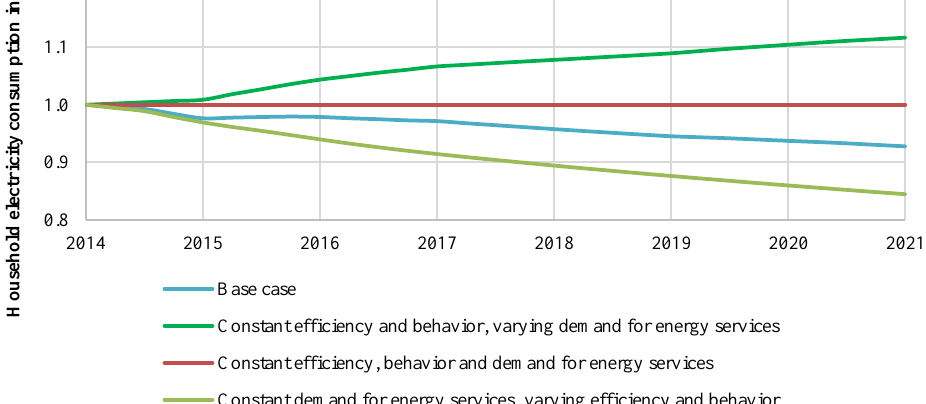
Fig. 13. Total household electricity consumption index for the base case (the reference), the case with constant efficiency of technologies and no change of behavior (reduction of use of light bulbs and electric appliances, no replacement of electric water heaters with alternatives), the case with constant efficiency (the same assumption as for the previous case) and constant demand for energy services (lighting, use of electric appliances, heating and cooling), the case with constant demand for energy services (as for the previous case); (the initial consumption: 1887